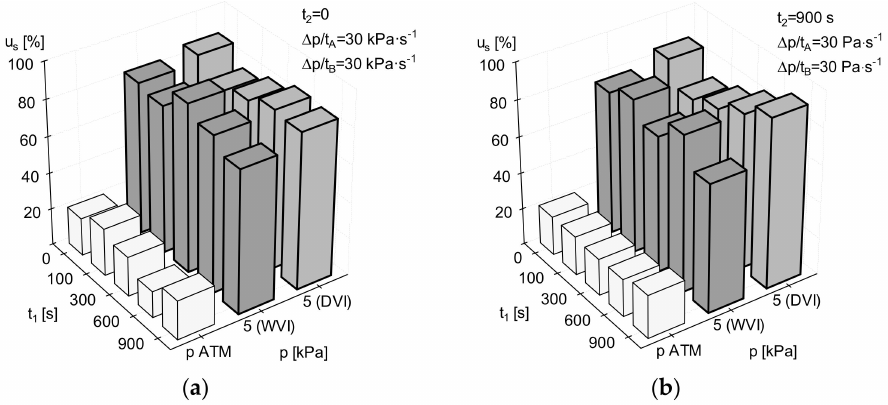
Figure 7. Changes in the percentage of apple tissue staining u S at time t 1 and di ff erent impregnation methods: ( a ) t 2 = 0 s, ( b ) t 2 = 900 s. Pressure change rate in the system 30 kPa · s − 1 .